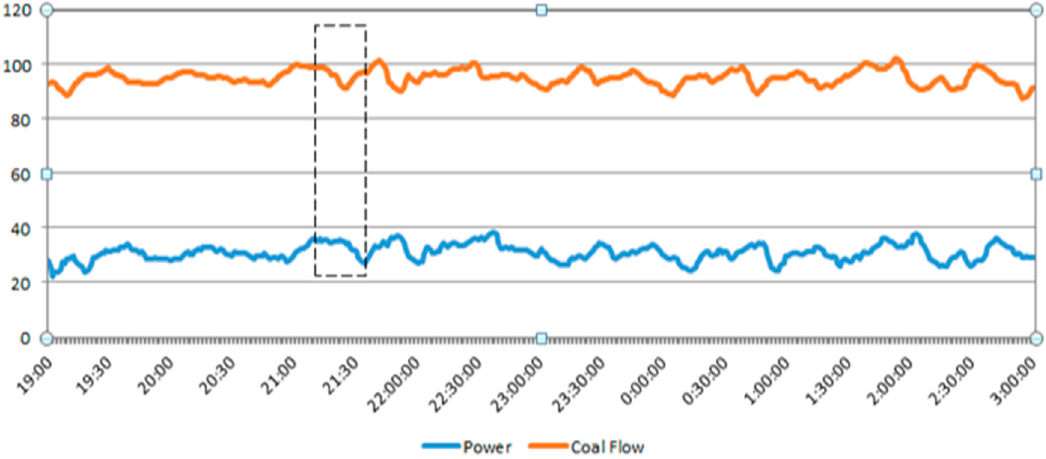
Figure 1. The correlated power and coal flow of the coal mil.